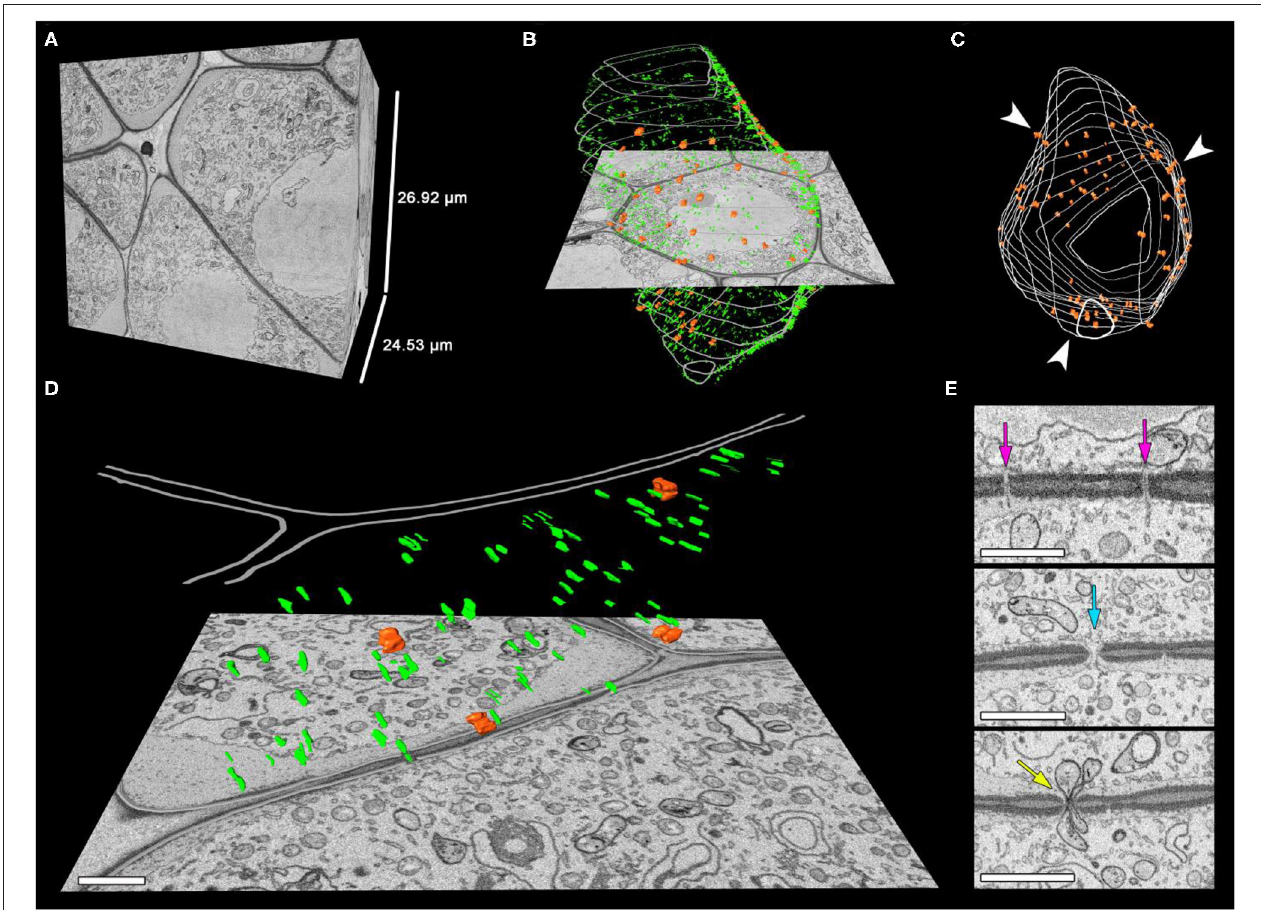
FIGURE 5 | Distribution of the intercellular channels in the tobacco meiocyte cell wall. (A–C) Three-dimensional reconstructions of the scanned tissue fragment from 673 serial images. The whole unlabeled tissue fragment that contains one meiocyte (A) , labeled CCs, plasmodesmata, and cell wall (B) , with only CCs and the cell wall labeled in the z-projection. (D) An enlarged cell wall fragment. (E) Sections with plasmodesmata and CCs. Orange represents CCs, green plasmodesmata, and gray the cell wall. Arrowheads indicate the CC clustering regions, the purple arrow points to plasmodesmata on a section, the turquoise arrow indicates a CC on a section filled with cytoplasm, and the yellow arrow points to a CC on a section with two plastids inside. Scale bars are 1 µ